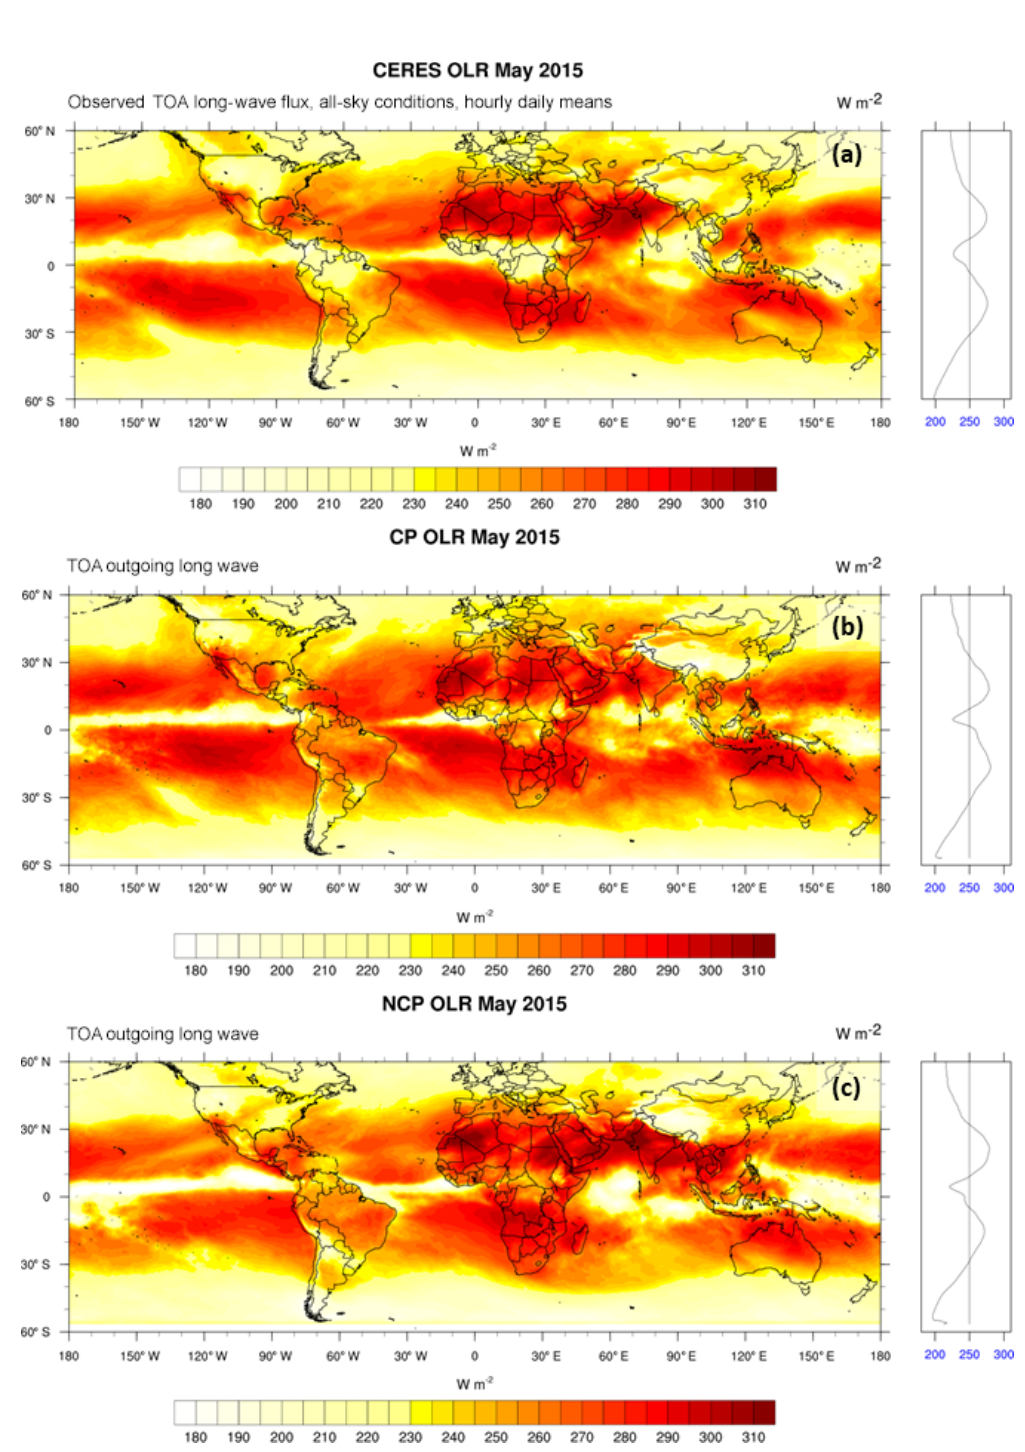
Figure 4. Monthly averaged TOA OLR (Wm − 2 ) during May 2015 together with the corresponding zonal mean. (a) displays the Clouds and the Earth’s Radiant Energy System (CERES) OLR, (b) displays the monthly mean OLR from the CP simulation, and (c) displays the monthly mean from the NCP